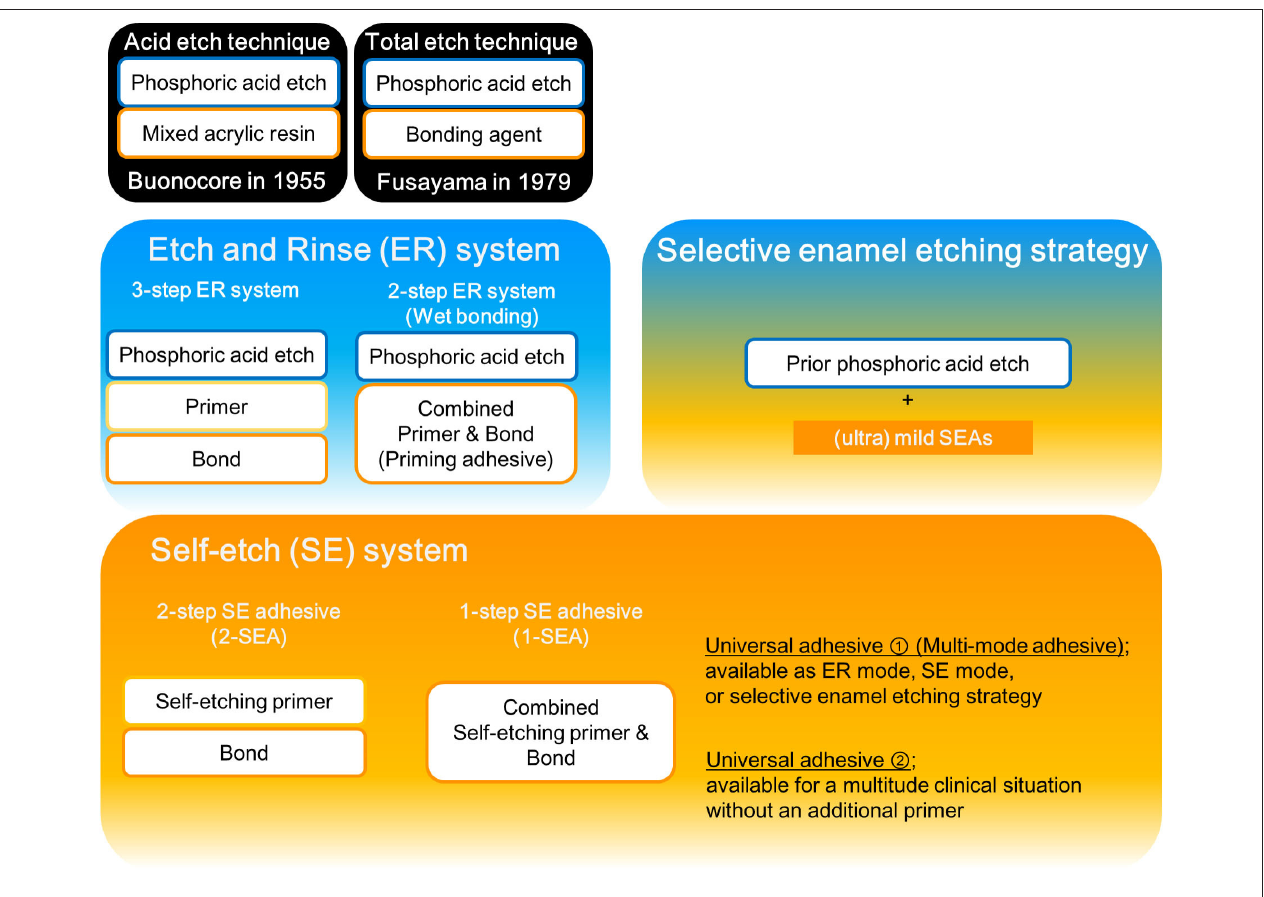
FIGURE 1 | The schematic outline of adhesive systems.